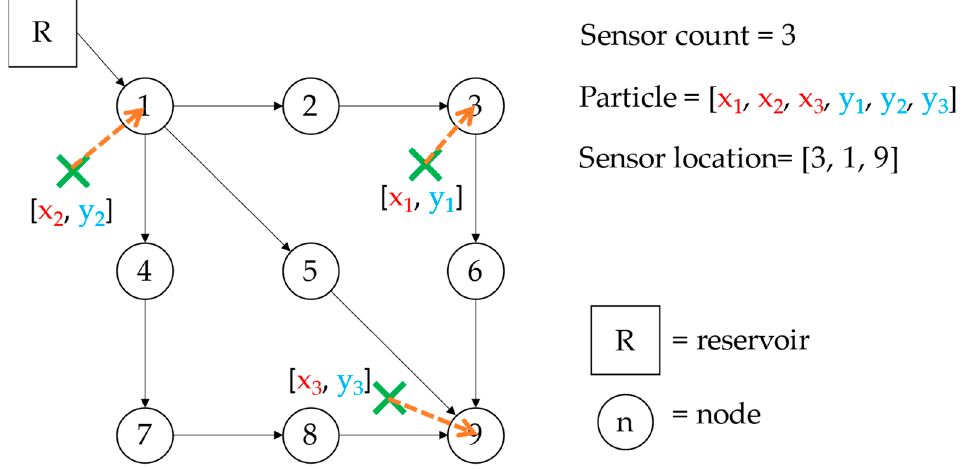
Figure 2. Example of search point behavior in the network.